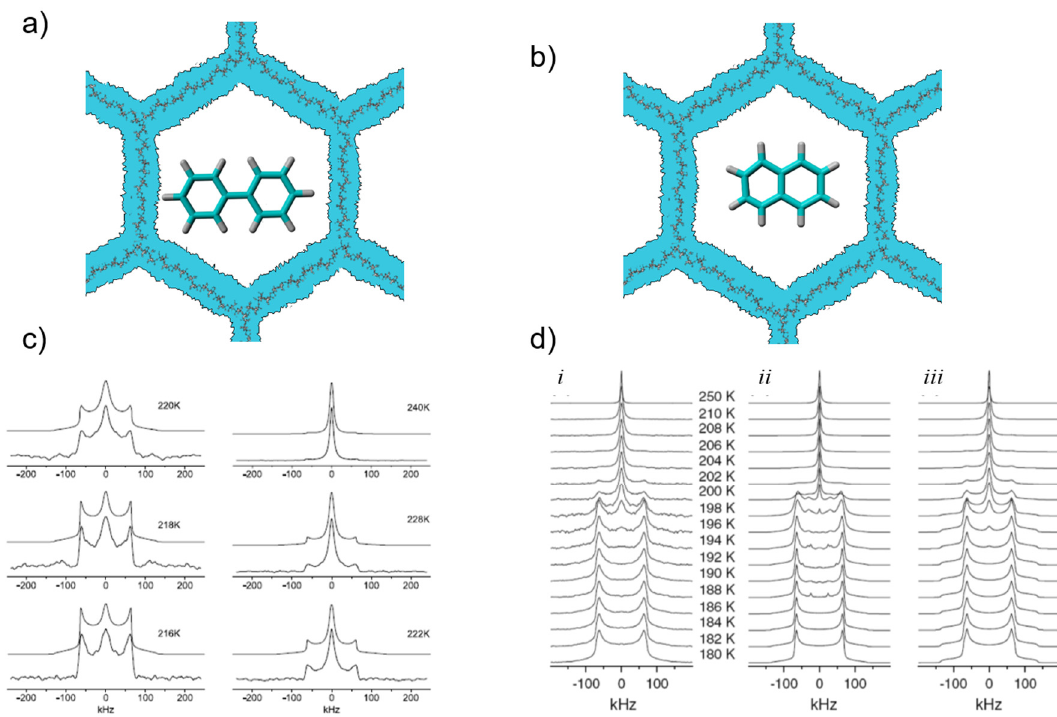
Figure 7. ( a ): cartoon of biphenyl [43] and ( b ) naphthalene [239] confined in MCM-41. In the case of biphenyl there are two possible rotational modes, namely, the rotation of a single phenyl ring and a molecular rotation. ( c ) experimental (lower traces) and simulated (upper traces) 2 H solid-echo NMR spectra of the melting process of biphenyl-d 10 inside silylated MCM-41 (d aver = 29 Å) at different temperatures [43]. ( d ): experimental variable temperature 2 H solid-echo NMR spectra of the melting process of naphthalene-d 8 inside MCM-41 (d aver = 33 Å) (i): experiment; (ii): simulated octahedral jump; (iii): two-phase model). All spectra are normalized to equal height (figure reproduced with permission from [176], copyright Walter de Gruyter and Company).